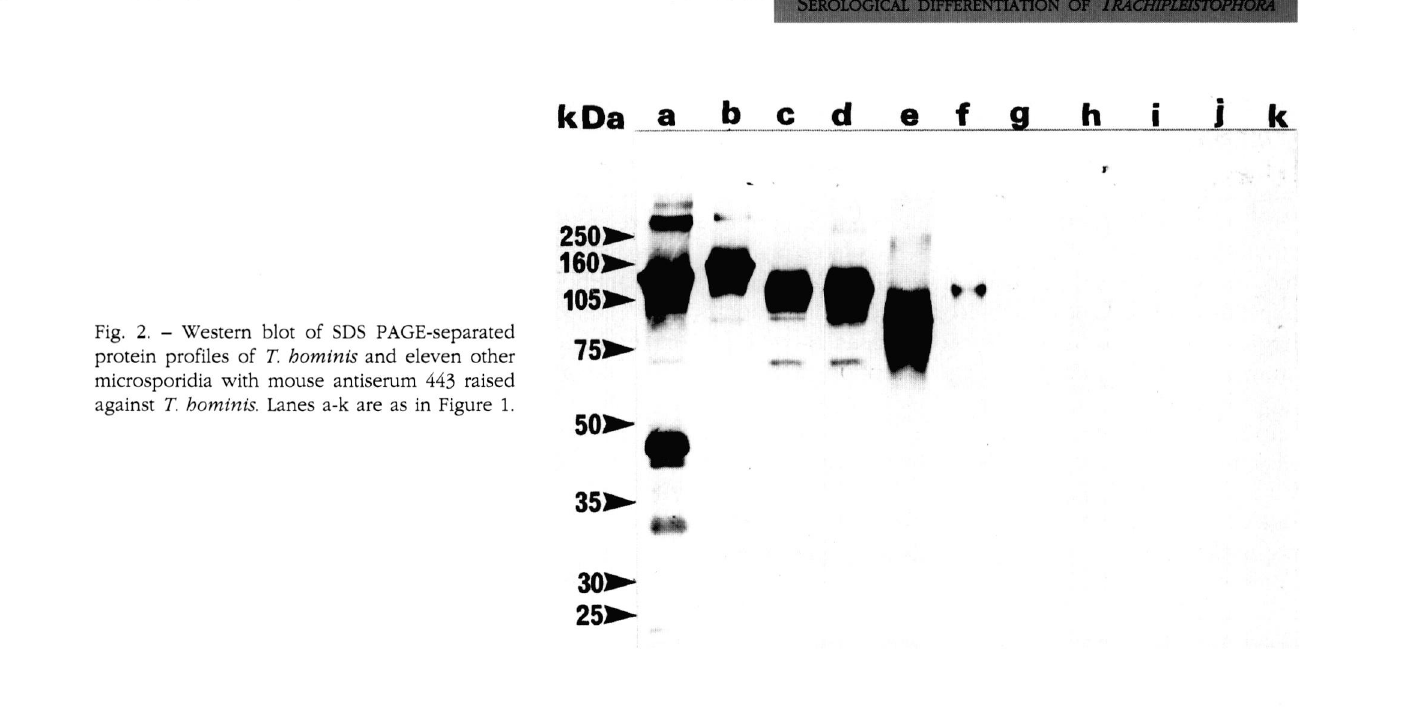
Fig. 2. - Western blot of SDS PAGE-separated protein profiles of T. hominis and eleven other microsporidia with mouse antiserum 443 raised against T. hominis. Lanes a-k are as in Figure